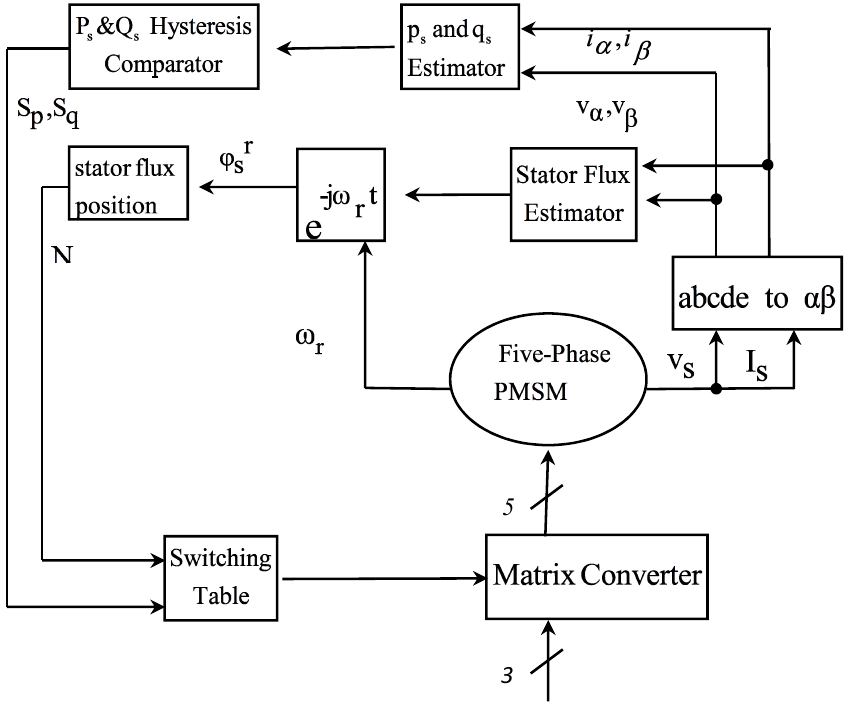
Figure 10. A block diagram of direct power control.